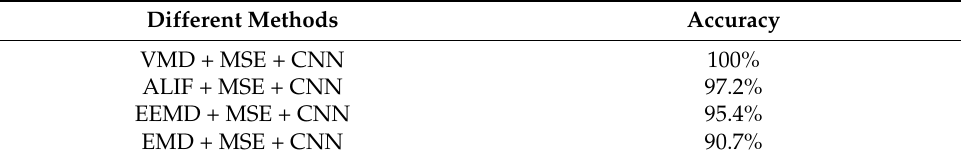
Table 3. Comparison of classification accuracy of four methods.